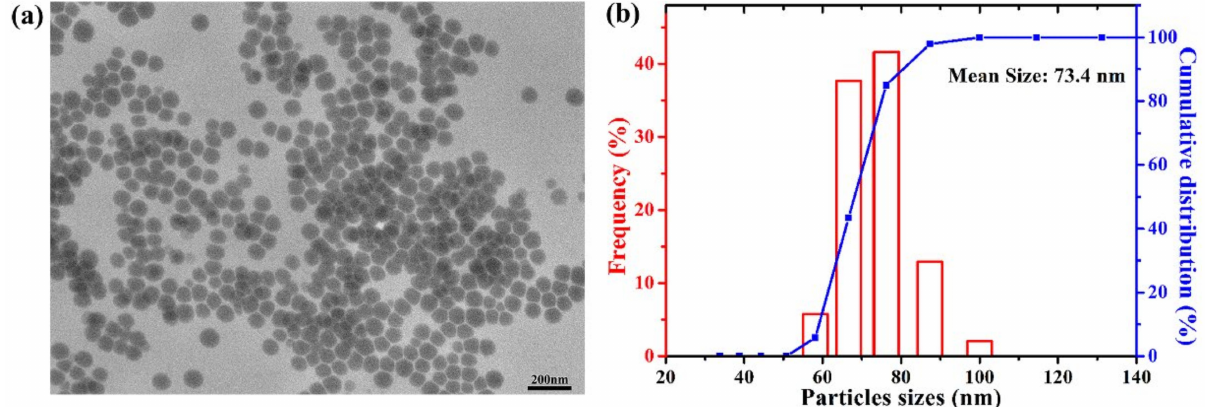
Figure 1. Characterization of CS-SeNPs. ( a ) TEM image; ( b ) DLS